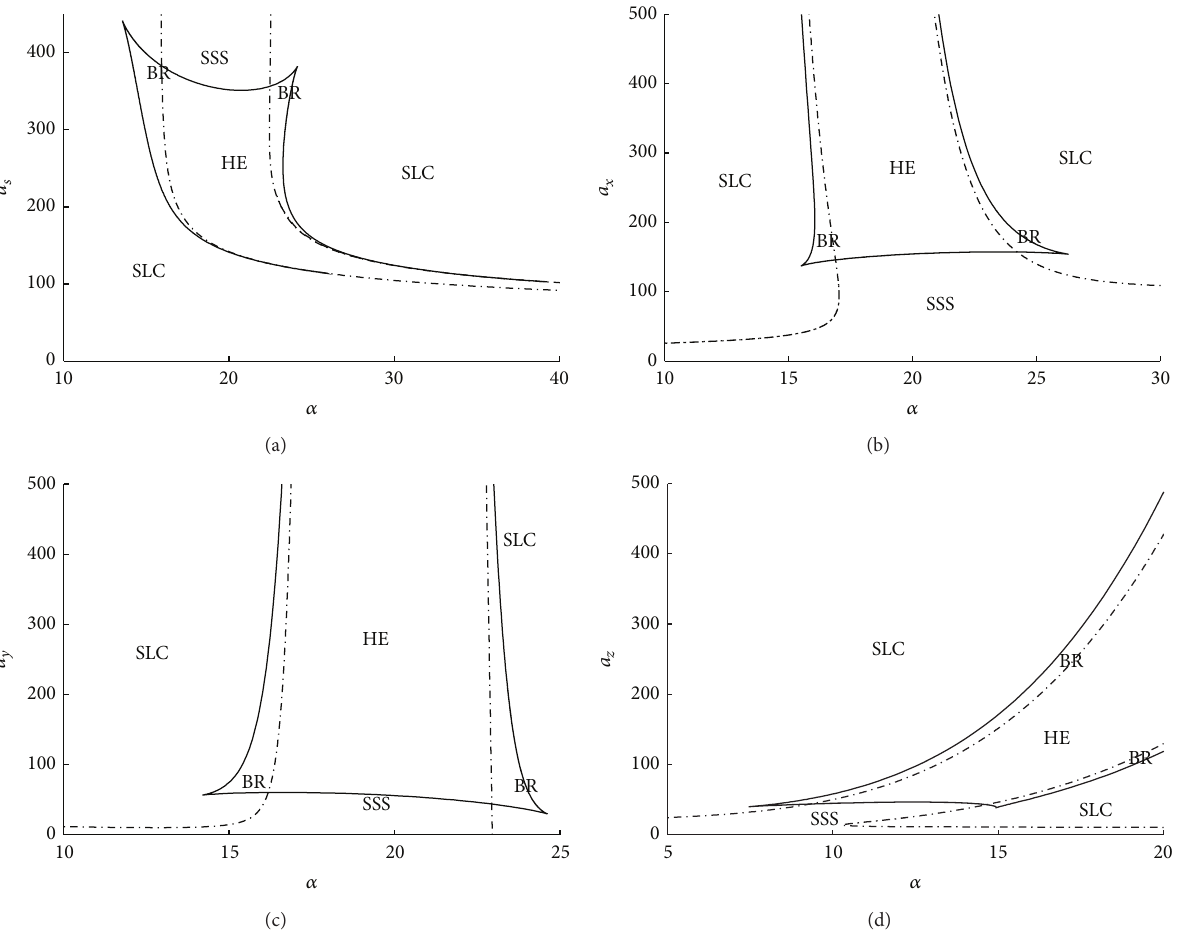
Figure 8: Bifurcation diagrams of two parameters showing the domains of different dynamical behaviors for model (2). (a) 𝛼 and 𝑎 𝑠 , (b) 𝛼 and 𝑎 𝑥 , (c) 𝛼 and 𝑎 𝑦 , and (d) 𝛼 and 𝑎 𝑧 for model